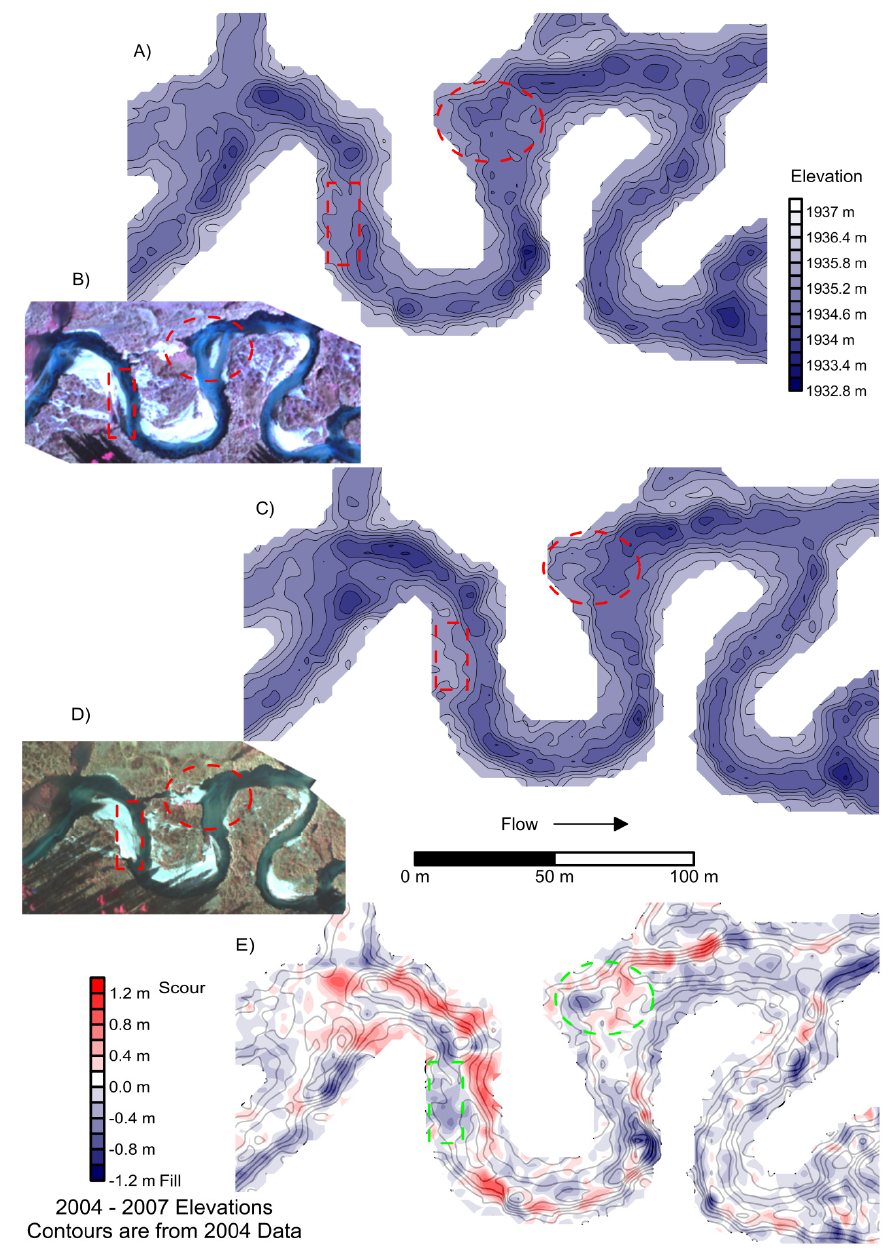
Figure 16. Change in a reach of Elk Creek, tributary to Middle Fork Salmon River, Idaho, between EAARL surveys in 2004 and 2007. Red and green ellipses and rectangles refer to areas discussed in text. (A) Bathymetry in 2004; (B) 2004 CIR photograph; (C) Bathymetry in 2007; (D) 2007 CIR photograph; (E) Colored intervals map the change in channel topography over the three year period, calculated as 2004 minus 2007 grid node elevations. Contours are from the 2004 bathymetric data and are included to give topographic context to the elevation difference